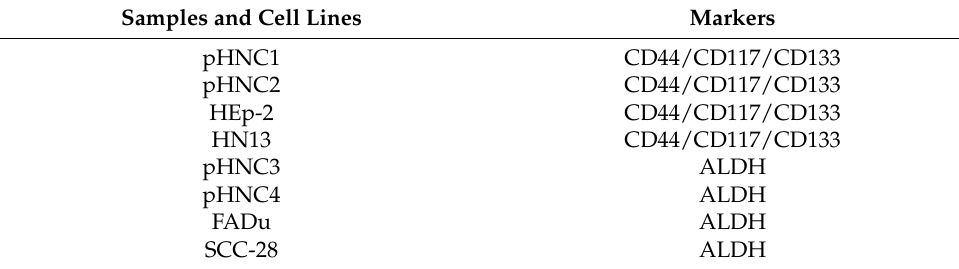
Table 2. Markers used for immunophenotyping and cell